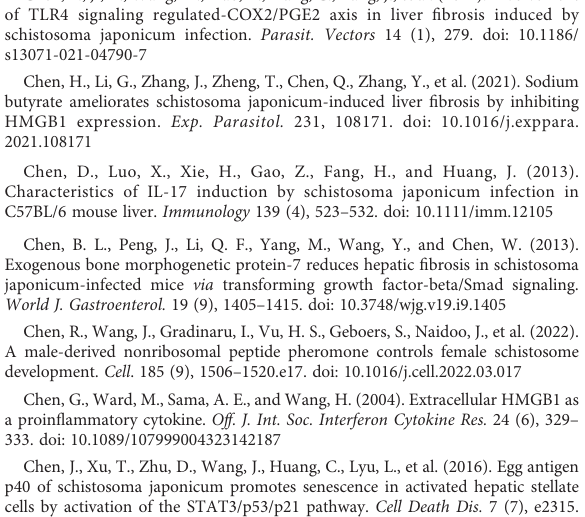
Figueiredo, A. L., Domingues, A. L., Melo, W. G., Tashiro, T., de Lorena, V. M., Montenegro, S. M., et al. (2016). Receptor antagonist of IL-13 exerts a potential negative regulation during early infection of human schistosomiasis. Scand. J. Immunol. 84 (5), 284 – 290. doi: